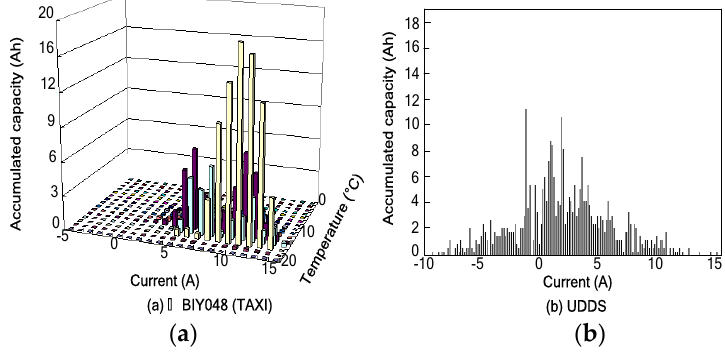
Figure 3. The capacity distributions in different driving cycles. ( a ) Jing BIY048 (TAXI); ( b )